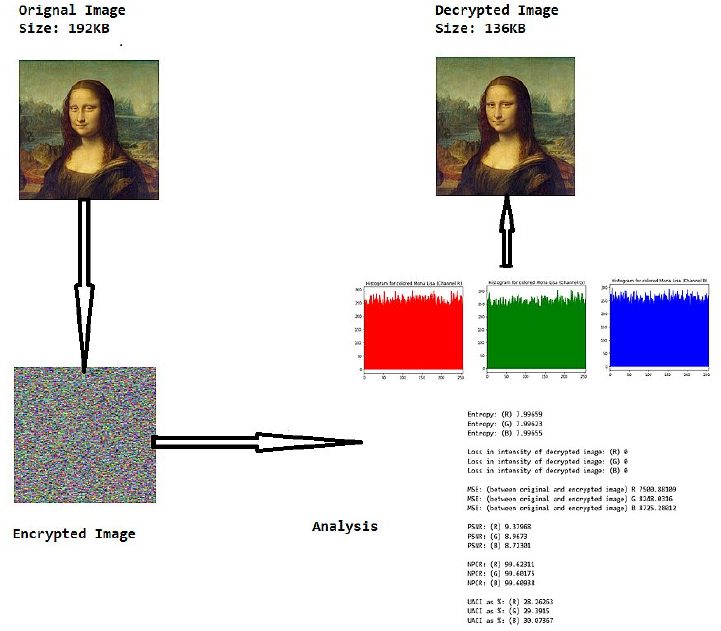
Figure 3. Parameter analysis of encryption and